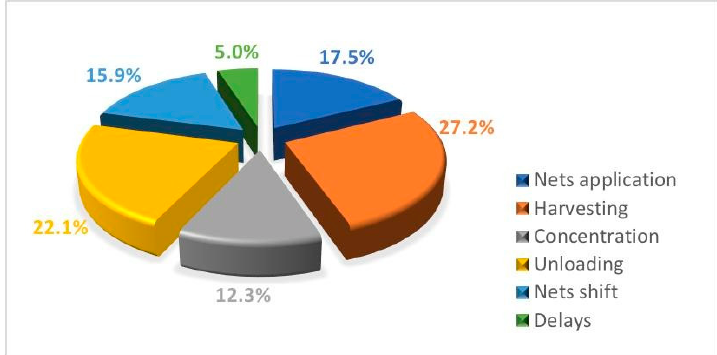
Figure 7. Percentage breakdown of working times in the different phases of olive harvesting.